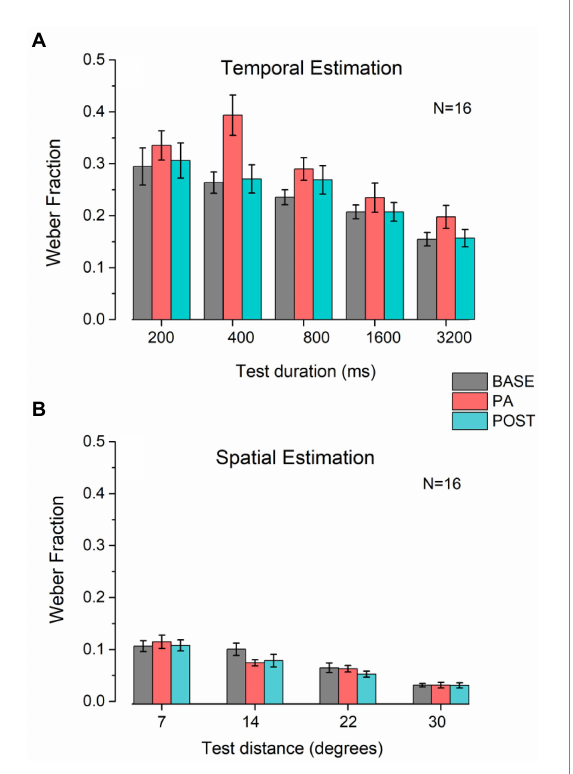
FIGURE 4 Weber Fraction on temporal and spatial estimation. (A) Bar plots represent the average Weber fraction for each session and duration tested in the temporal estimation task. Error bars represent SEM. (B) Bar plots represent the average Weber fraction for each session and distance tested in the spatial estimation task. Error bars represent